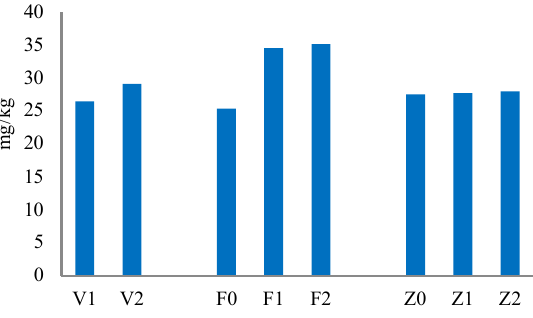
Fig. 6. Mean comparison of Variety, Iron and Zinc simple effects on Fe content